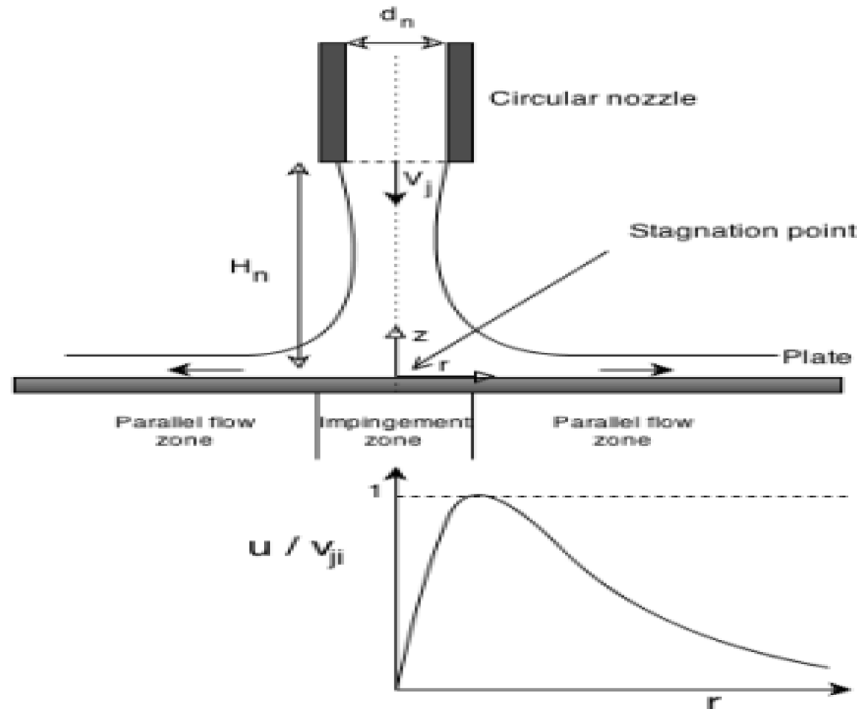
Fig. 1 Schematic of free-surface jet and liquid velocity profile parallel to surface circular jets